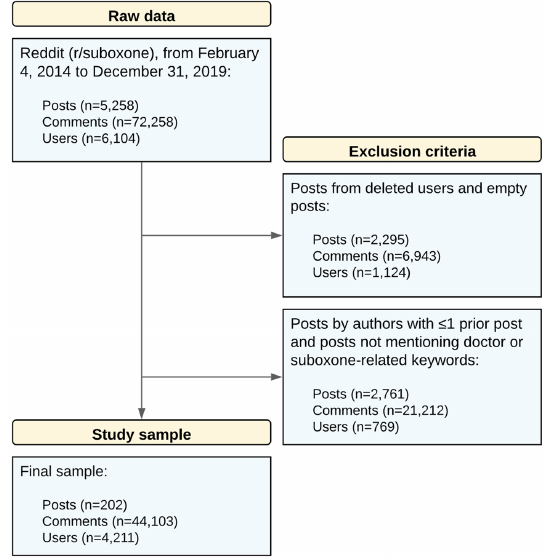
Figure 1. Application of exclusion criteria to raw data for obtaining the study sample.